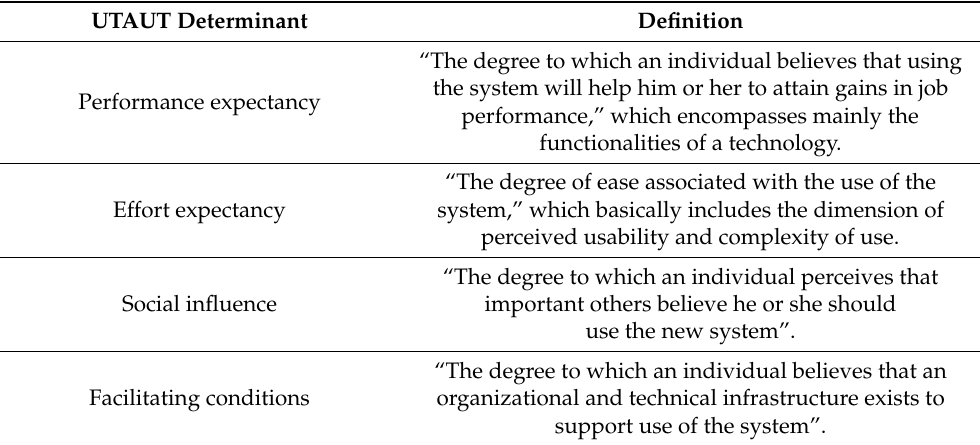
Table 1. Definitions of the core direct determinants of UTAUT [41].